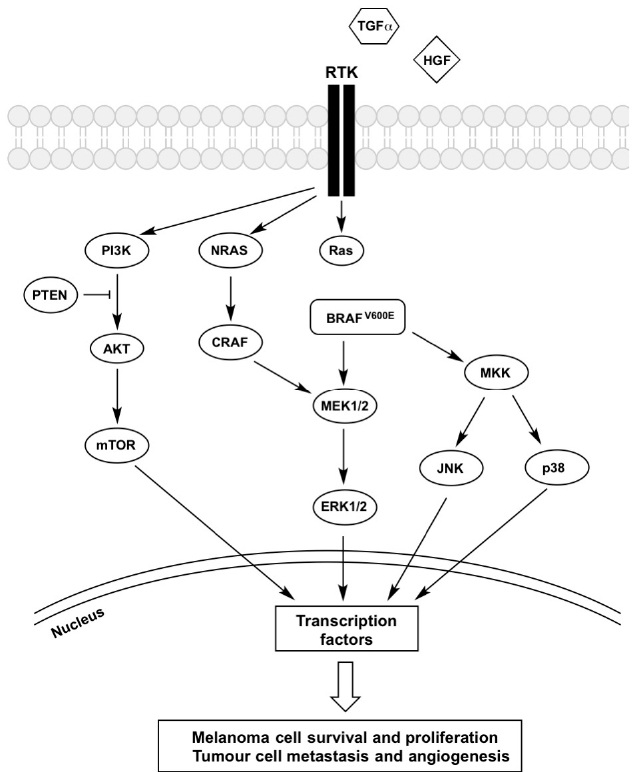
Figure 1. Mechanisms of BRAFi resistance converge on constitutive ERK signalling. Regardless of its upstream activator RAS, BRAF V600E is constantly activated, and vemurafenib treatment was shown to inhibit the kinase. However, the increased secretion of growth factors (HGF and TGF- α ) coupled with the overexpression of receptors (PDGFR β , IGFR1, EGFR and c-Met) trigger the activation of signalling cascades inside melanoma cells that bypasses BRAFV 600E inhibition, which confers resistance to these therapeutic agents. Both MAPK and PI3K-AKT-mTOR pathways are activated and the signal is passed into the nucleus, which triggers phosphorylation of transcription factors, leading to melanoma cells survival and proliferation as well as tumour metastasis and angiogenesis. Description of the abbreviations listed above are contained within this review.